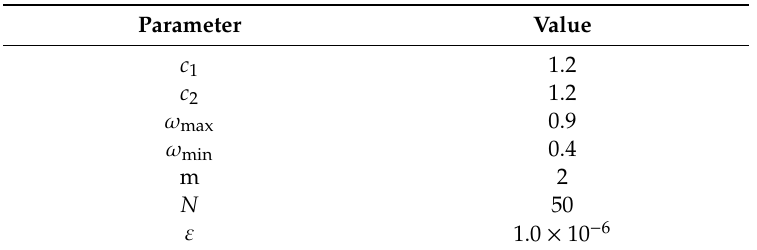
Table 2. Experimental parameter